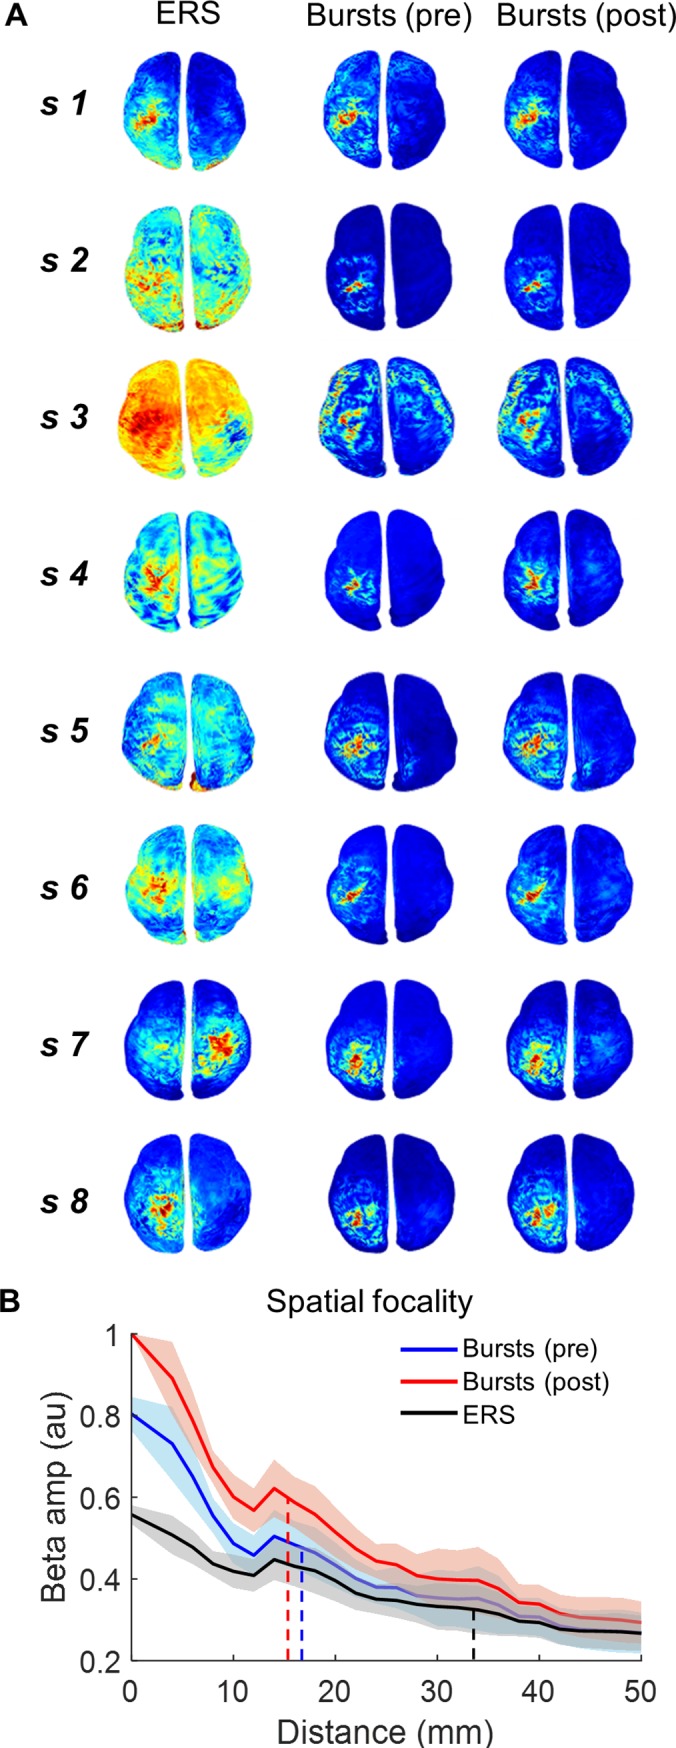
Motor cortical beta bursts are spatially focal.(A) Spatial topography of the average beta amplitude in source space for each individual subject (s1–s8), for the subject-specific (660.8 ± 12.1 milliseconds post button press) peak of the ERS, and the average burst for the pre- and post-movement periods, respectively. Colour ranges are individualised to highlight the spatial spread of activity independent of individual differences in SNR and absolute beta amplitude levels. Red colouration represents maximum activity and blue the minimum amplitude per subject (performed independently for ERS (left) and burst analyses (middle and right plots). Data are not baseline normalised within subject. Beta bursts have a more focal topography than the ERS (see also S1 Video and S2 Video). (B) Spatial focality of bursts versus average ERS across all subjects. The normalised decrease in beta amplitude with distance from left M1, for all subjects ± SEM (normalised within the subject by dividing the amplitude by the post-movement average burst maxima at the centre of M1), for the ERS, and the pre- and post-movement bursts. This confirms the faster drop-off in beta amplitude with distance from M1 for the bursts (FWHM [dashed line]: pre-movement (blue) −17.5 ± 2.7 mm; post-movement (red) −15.5 ± 2.2 mm), compared with the average ERS (FWHM [black]: 33.5 ± 5.2 mm), indicating increased amplitude and spatial focality. The underlying data can be found at https://osf.io/eu6nx/. ERS, event-related synchronisation; FWHM, full width half maximum; SNR, signal-to-noise ratio.